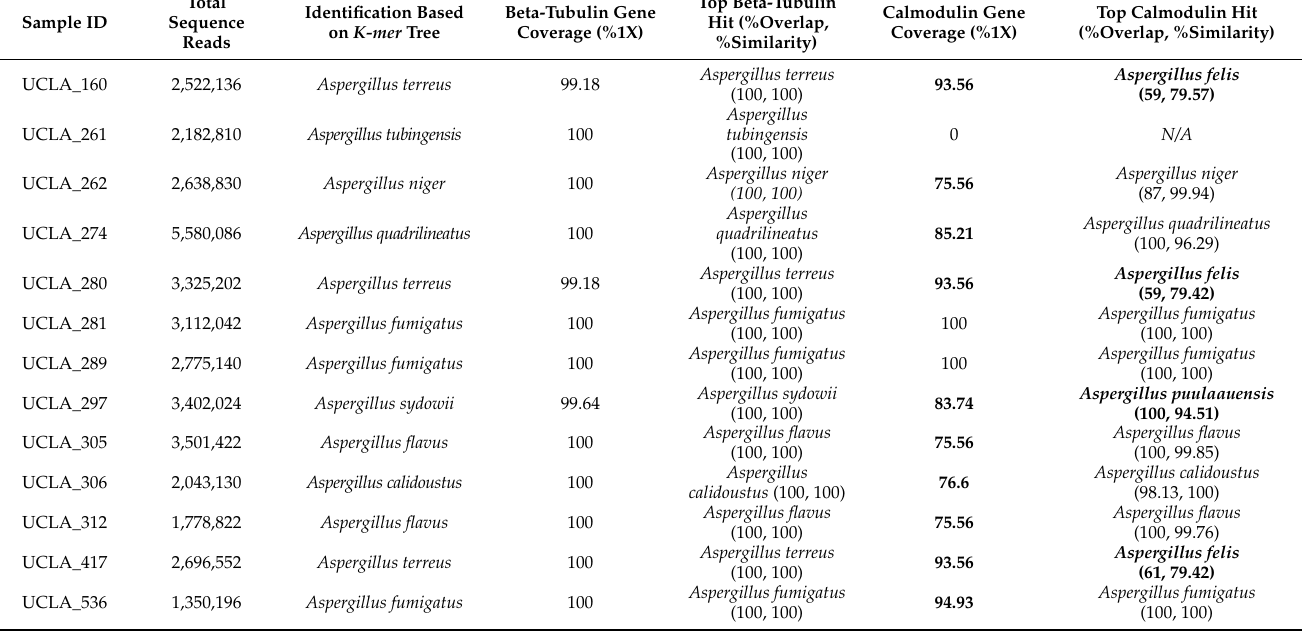
Table 2. Aspergillus species identification based on k-mer Tree, beta-tubulin, and calmodulin gene